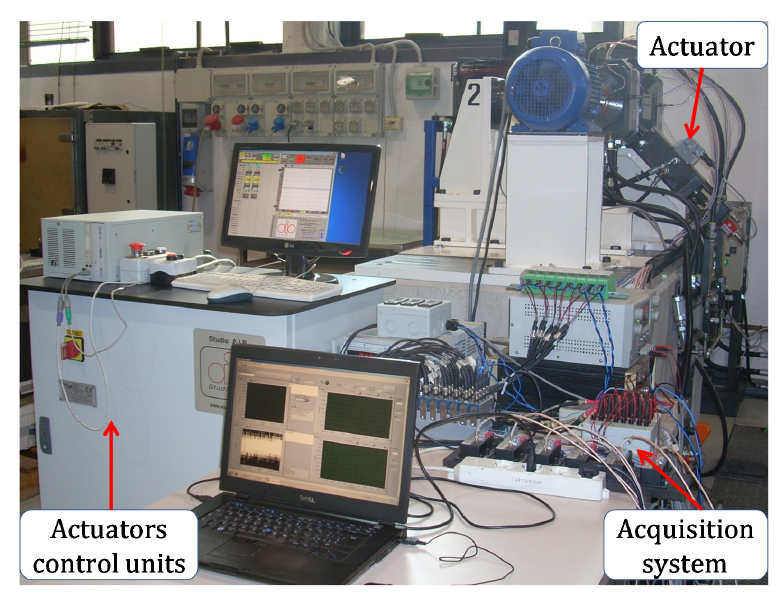
Figure 9. Signal processing system.